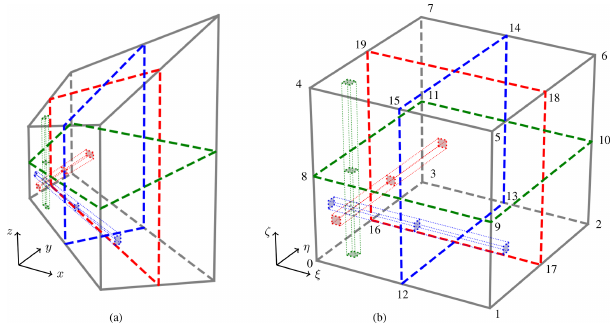
Figure 4. Fluxes used for 3-D interpolation on a C grid for (a) the physical cell and (b) the unit cell. The node indices in (b) are used to define the faces in Eq.